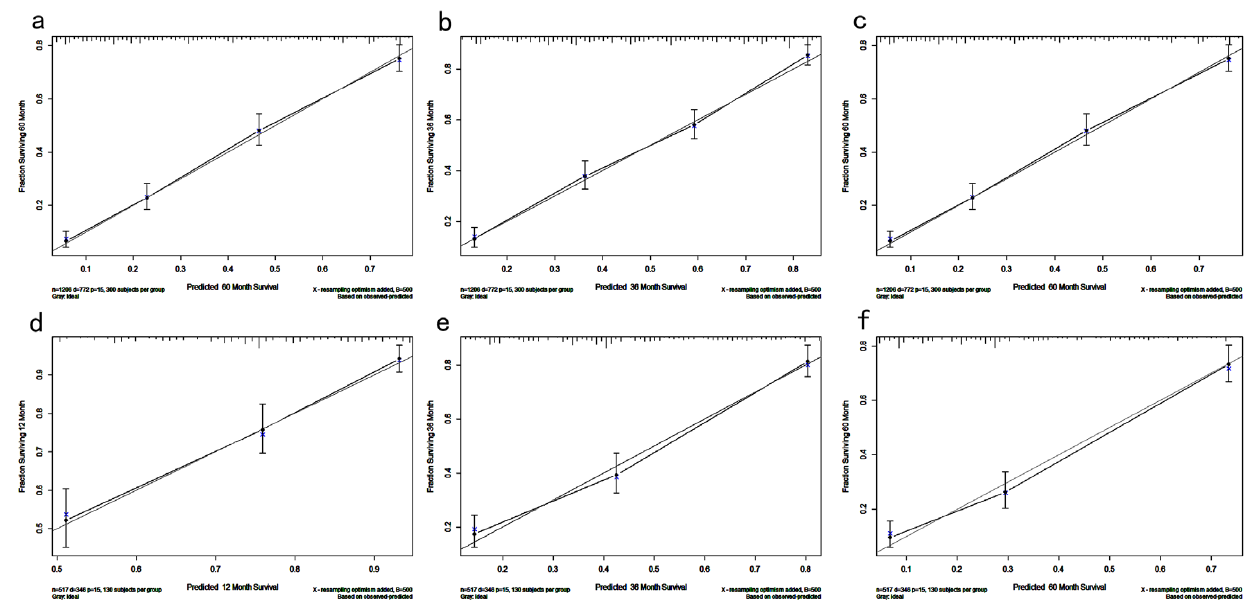
Table 5. Prognostic efficiency of the nomogram of OS.